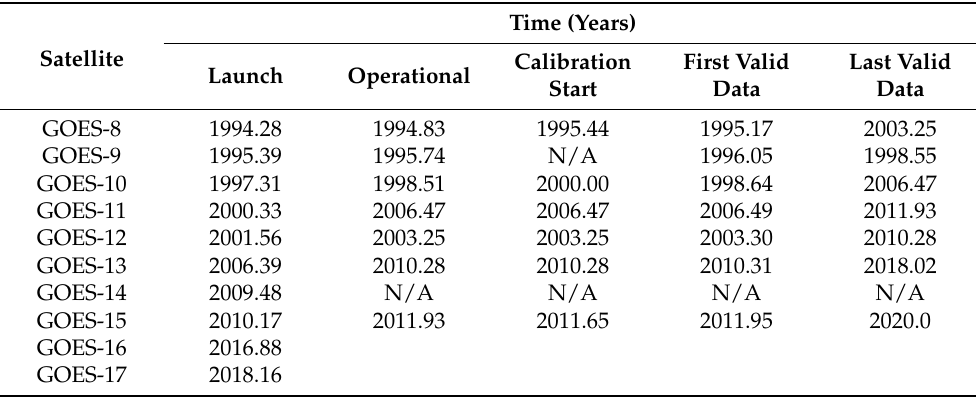
Table 1. Dates used in the calibration of GOES-IP